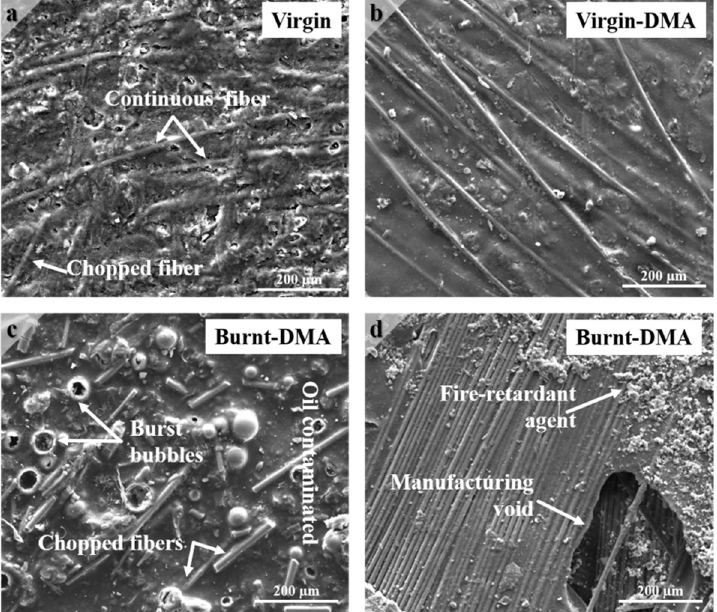
Figure 2. Collage of SEM micrographs of ( a ) virgin E-Glass/Epoxy skin surface; ( b ) the surface of a virgin sample after DMA testing, and ( c , d ) surface of deployed specimens after DMA testing. (Micrograph c is for portion of the sample with oil contamination while micrograph d is from the same sample but from region that was contamination-free).